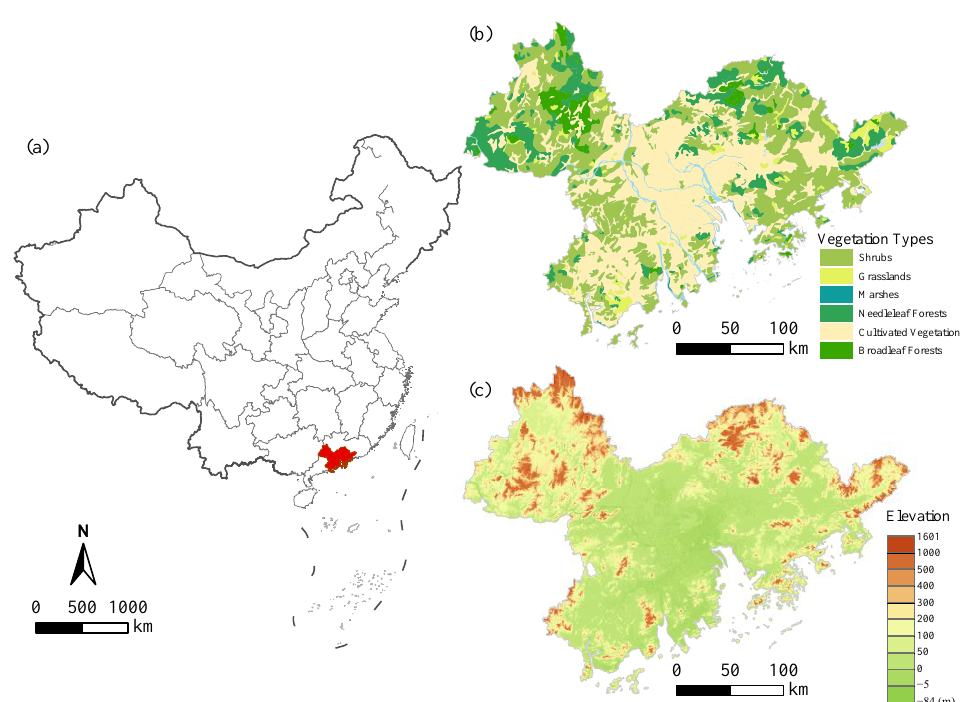
Figure 1. Location of the Guangdong−Hong Kong−Macao Greater Bay: ( a ) location in China; ( b ) vegetation type map; ( c ) elevation map.